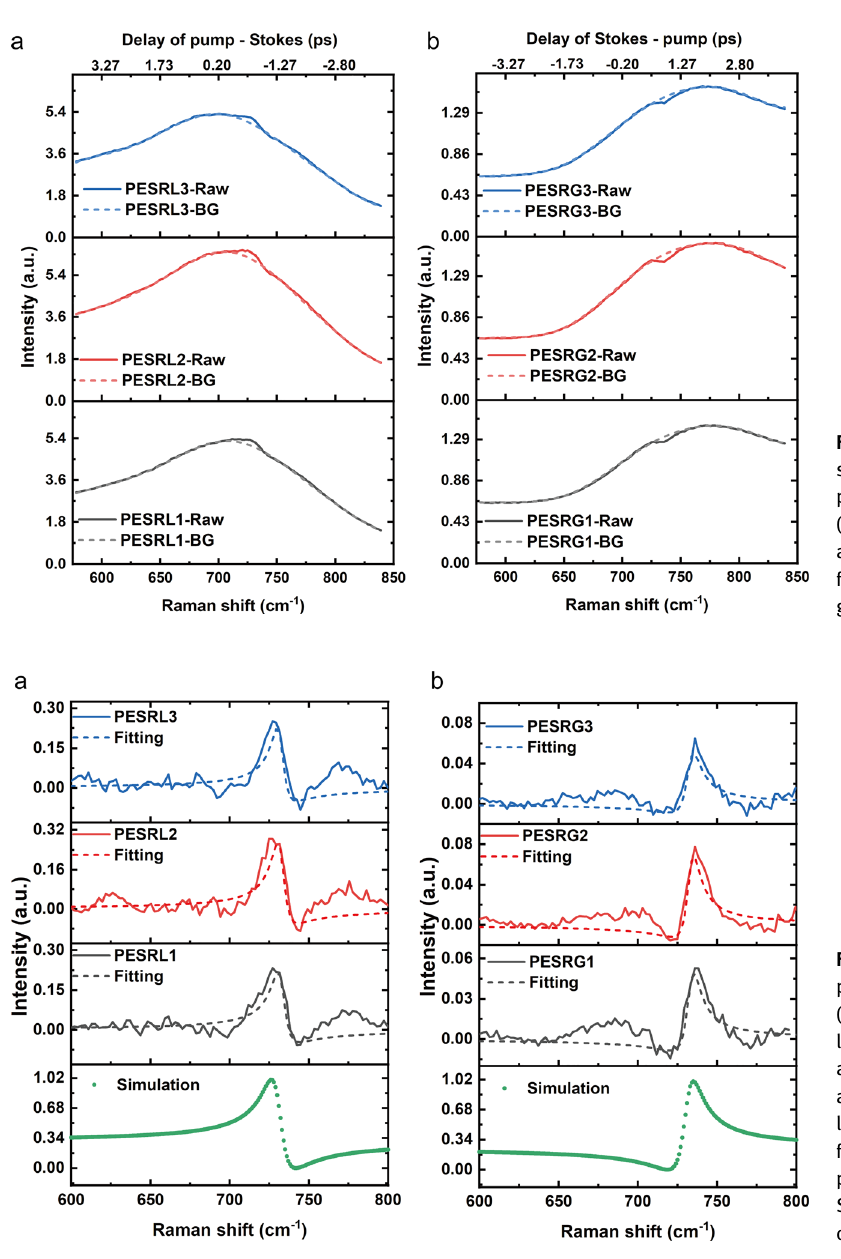
Figure 4: Three raw plasmon-enhanced stimulated Raman loss (PESRL) (a) and plasmon-enhanced stimulated Raman gain (PESRG)(b)spectraofadenineadsorbedon aggregated Au NPs which are obtained from different locations. Fitting back- grounds are displayed as dash lines.